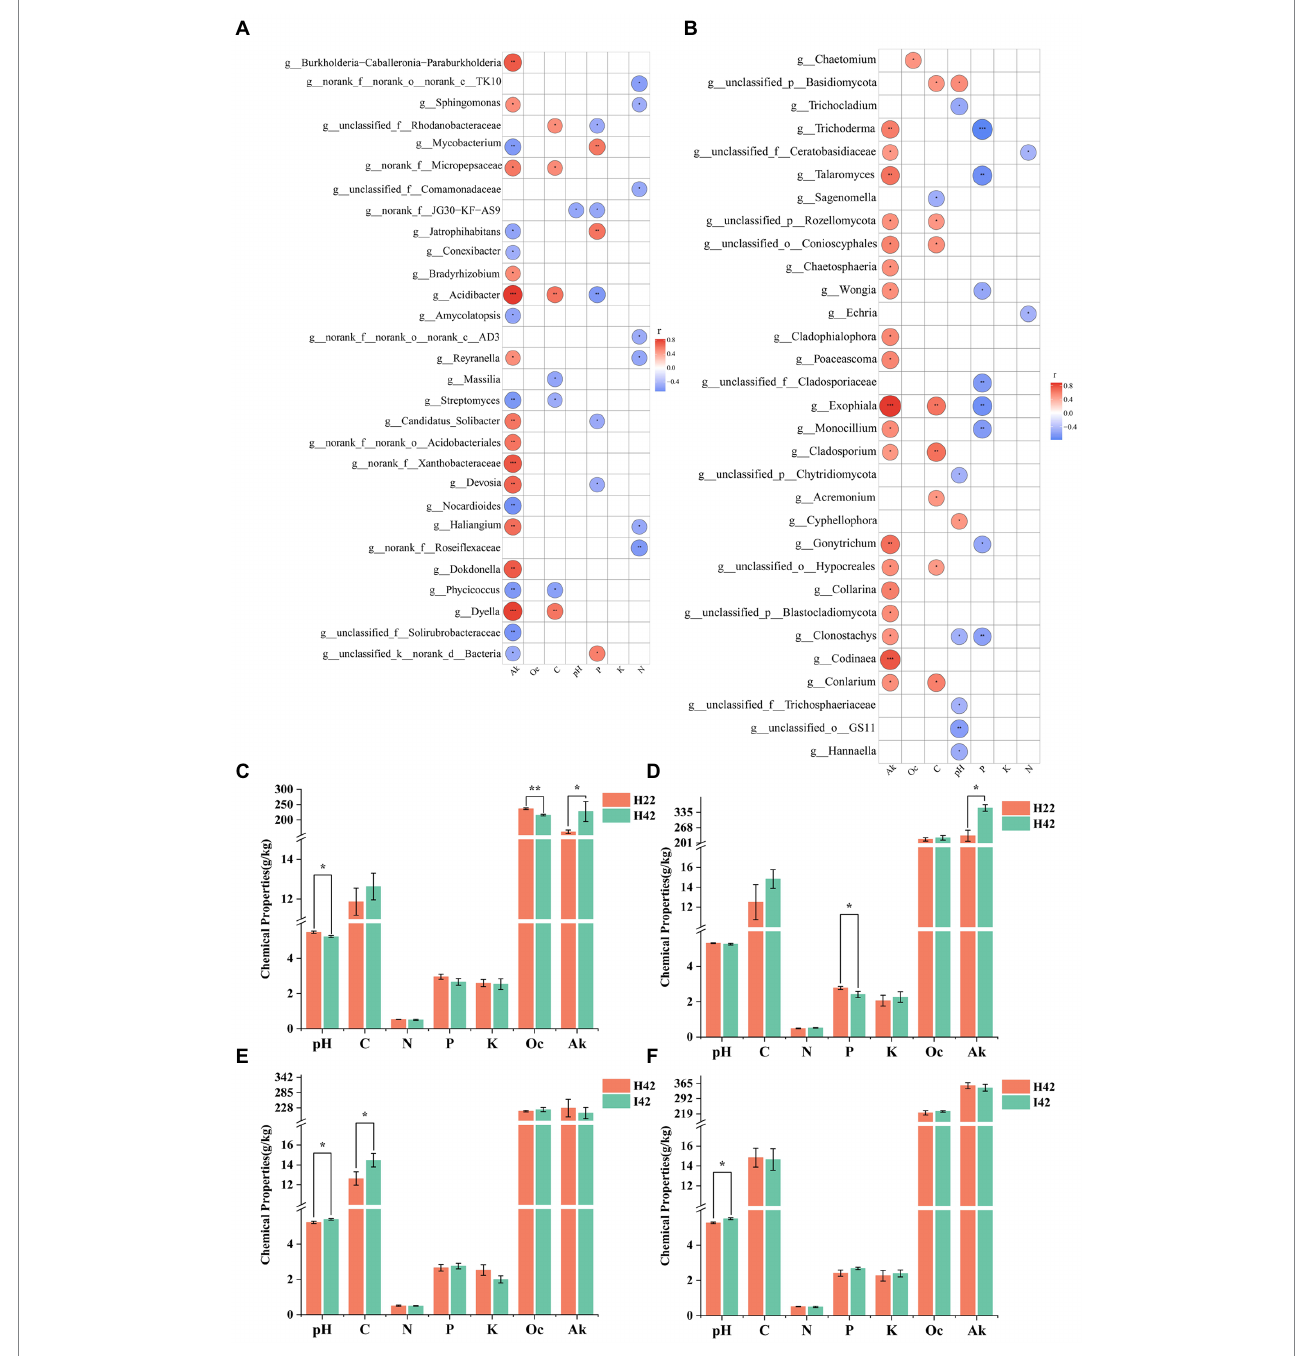
FIGURE 5 Heatmap of the correlation between the microbiome in soil and soil chemical properties, and statistical histogram of differences in soil chemical properties. Fk for Available Potassium. Oc for Activated organic carbon. C for organic carbon. K for Total potassium. N for Nitrogen. P for Phosphorus. Correlation was calculated by Spearman’s correlation coefficient. Significance markers p > =0.05 no marker (white), 0.01 < p < 0.05 markers: *, 0.001 < p < =0.0 markers: **, p < =0.001 markers: ***. (A) Heat map of the correlation between microbiome and soil chemistry at the level of bacterial soil genera. (B) Heat map of the correlation between microbiome and soil chemistry at the level of fungal soil genera. Positive correlation marker in red, negative correlation marker in blue. (C) Soil chemistry between species in the topsoil. (D) Soil chemistry between root soil species. (E) Soil chemistry before and after insect infestation of the topsoil. (F) Soil chemistry before and after insect infestation of the root soil. Soil pH. Soil organic carbon. Soil Available Potassium. Soil total Nitrogen. Soil Total Phosphorus. Total soil potassium. Activated organic carbon. pH determination by potentiometric method, organic carbon determination by potassium dichromate external heating method, total nitrogen determination by Kjeldahl method, total phosphorus determination by NaOH fusion-molybdenum antimony anti-colorimetric method, total potassium determination by NaOH fusion, flame photometric method, easily oxidized organic carbon determination by potassium permanganate oxidation method, available potassium determination by NH4DAc leaching, flame photometric